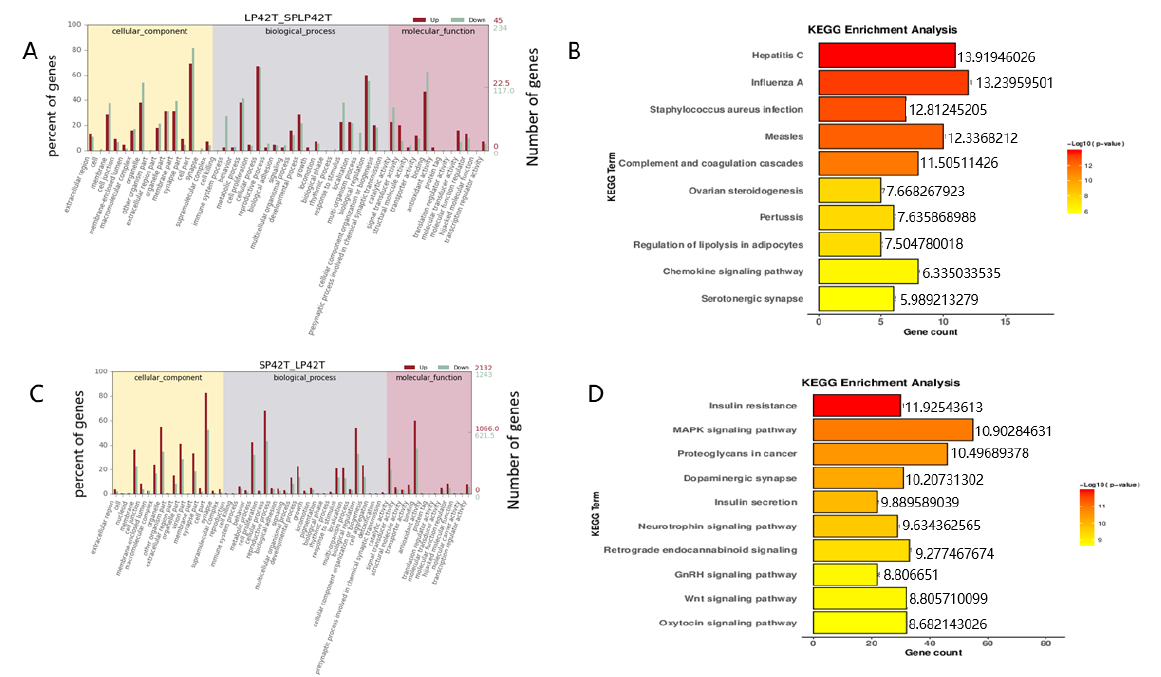
Figure 4. An analysis of GO and KEGG enrichment in the thyroid gland was performed. ( A ) Analysis of GO function of DE-mRNAs in LP42 and SPLP42. ( B ) Ten major KEGG enrichment pathways of DE-mRNAs were observed between LP42 and SPLP42. ( C ) Analysis of GO function of DE-lncRNAs in SP42 and LP42. ( D ) Ten major KEGG enrichment pathways of DE-lncRNAs were observed between SP42 and LP42.